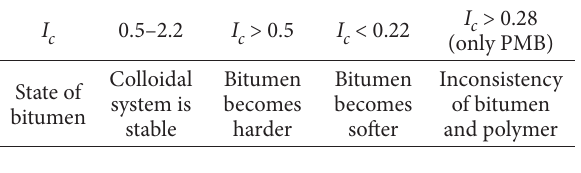
table 1. Requirements to the Colloidal Instability Index ( Gaestel, Smadja 1971)